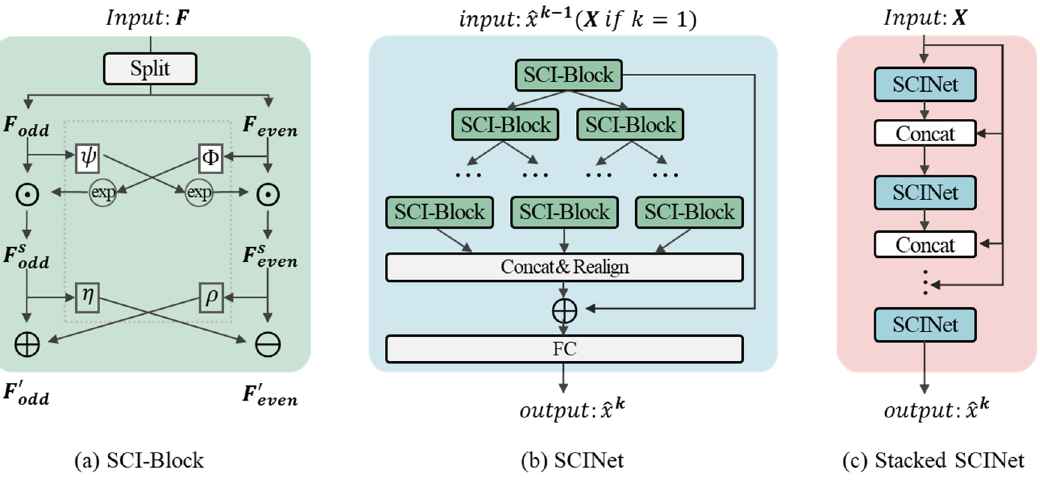
Figure 11. Overall architecture of SCINet (reproduced from ref. [11]).